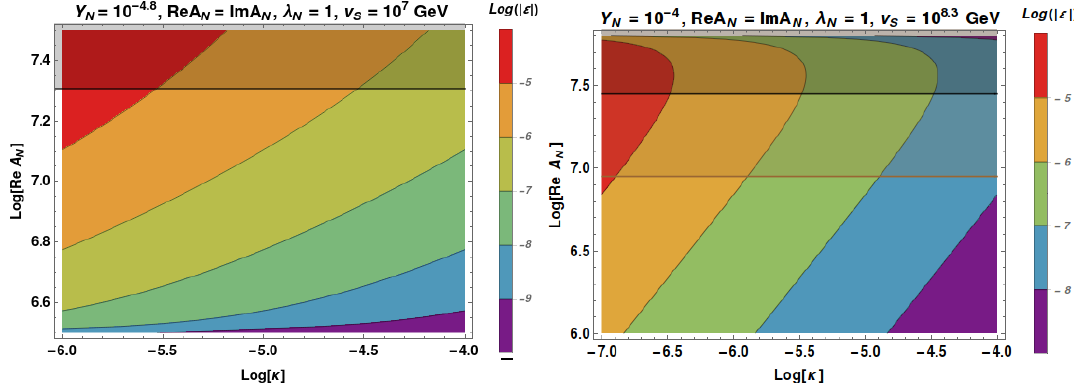
Figure 5 . The contour plots of " in Re A N (cid:0) (cid:20) plane considering A N complex. The left panel shows only the out-of-equilibrium bound ((cid:0) H ( z = 1), in horizontal black solid line) with a generic ’ A N . In the right panel the horizontal brown solid line marks the leading order approximation in the soft-term A N ( A 2 =M 2 10 (cid:0) 3 ), while the black line is the out-of-equilibrium bound. All 1 ’ N logarithms are to the base